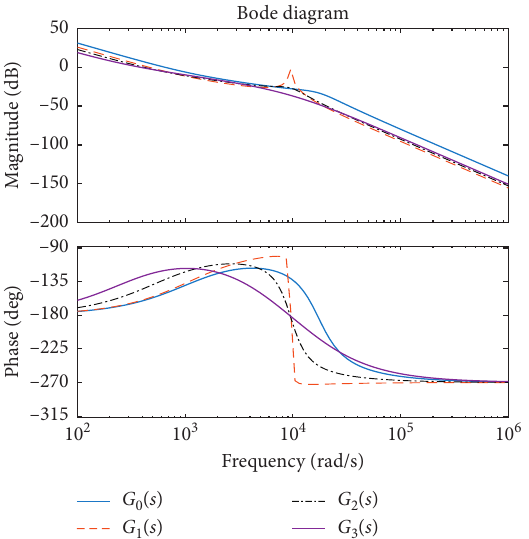
Figure 9: Board diagram of system loop gain under different controllers.